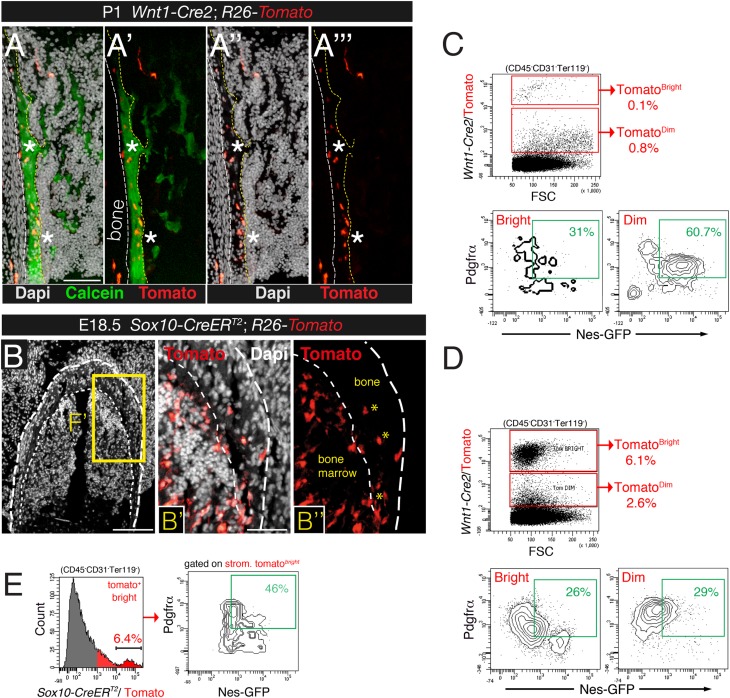
Contribution of trunk neural crest to bone marrow stromal lineages.(A-A′′′) Bone marrow section from newborn Wnt1-Cre2;R26-Tomato pup stained with calcein to mark calcium deposition (green), showing Wnt1-Cre2-traced Tomato+ osteoblasts (red) in calcifying areas (asterisks). Scale bar = 100 μm. (B) Representative bone section of an E18.5 Sox10-CreERT2;R26-Tomato mouse showing Tomato+ osteocytes (asterisks) and bone-lining osteoblasts (red). Dashed line depicts the bone contour. Nuclei were counterstained with DAPI (gray). (C and D) Representative flow cytometry plots of bone marrow stained with Pdgfrα from neonatal (D) and 4-week old (C) Wnt1-Cre2;R26-Tomato;Nes-Gfp mice, after gating on the stromal (CD45- CD31- Ter119-) population. (E) Representative flow cytometry histogram of bone marrow cells from E18.5 Sox10-CreER;R26-Tomato;Nes-Gfp embryos, induced with tamoxifen at E9.5, after gating on the tomato-bright population. Scale bars: 200 μm (B), 100 μm (A, B′).